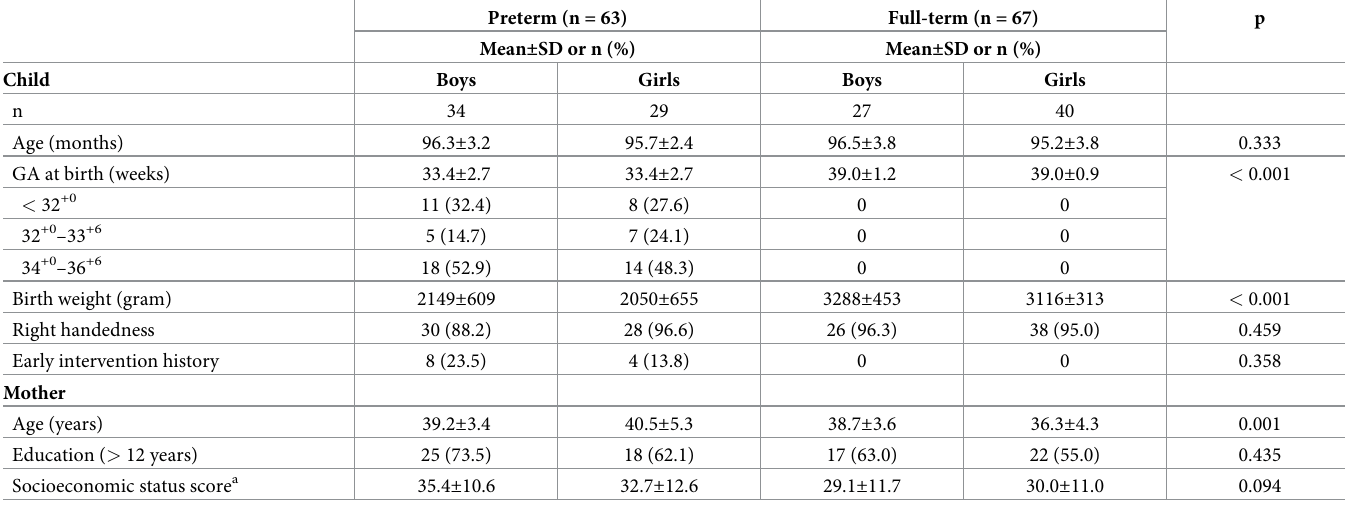
Table 1. The characteristics of preterm and full-term children in grade two.